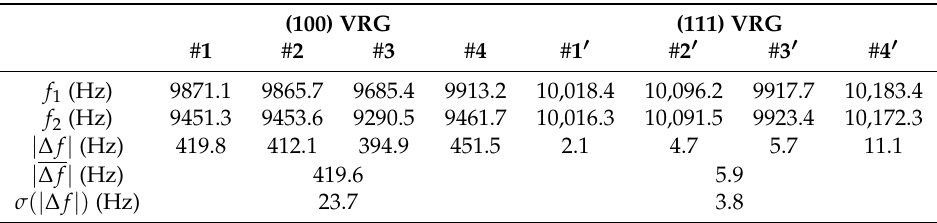
Table 3. Frequency test data of (100) and (111)